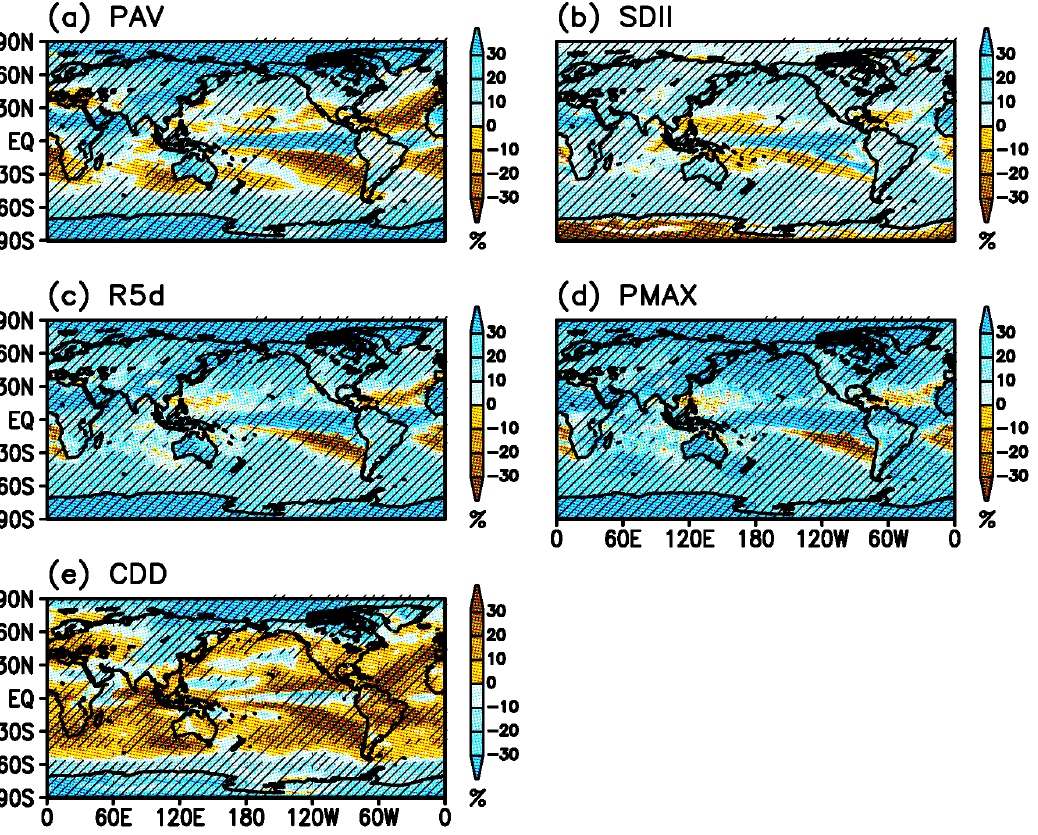
Figure 6. Future changes in precipitation indices (Table 3) by averaging all 12 simulations. Change is normalized by the present-day climatology. Unit is %. Hatched regions show changes above the 95% significance level. ( a ) PAV; ( b ) SDII; ( c ) R5d; ( d ) PMAX; ( e ) CDD. ( a ) is the same as Figure 5t. Future R5d and CDD changes over land projected by the MME mean of CMIP5 AOGCMs are